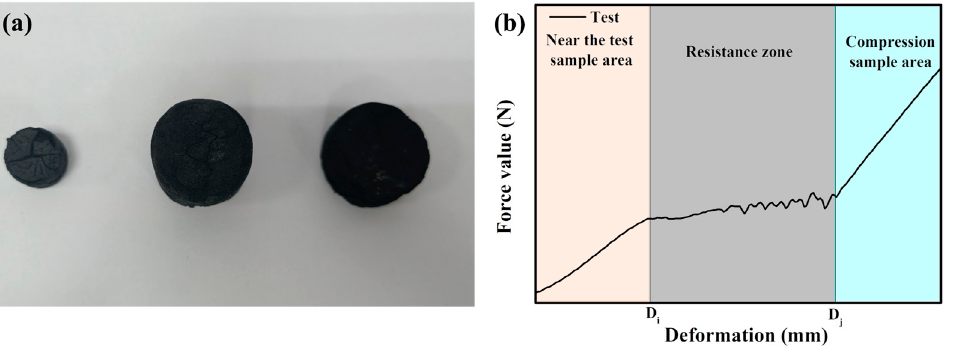
Figure 3. ( a ) Modified carbon material sample (from left to right are GL-TEOS, CP-IG, and CP-GP); ( b ) schematic diagram of a three-interval compressive strength measurement curve. Left: near the test sample area; middle: stress resistance zone; right: the area where the sample was crushed.